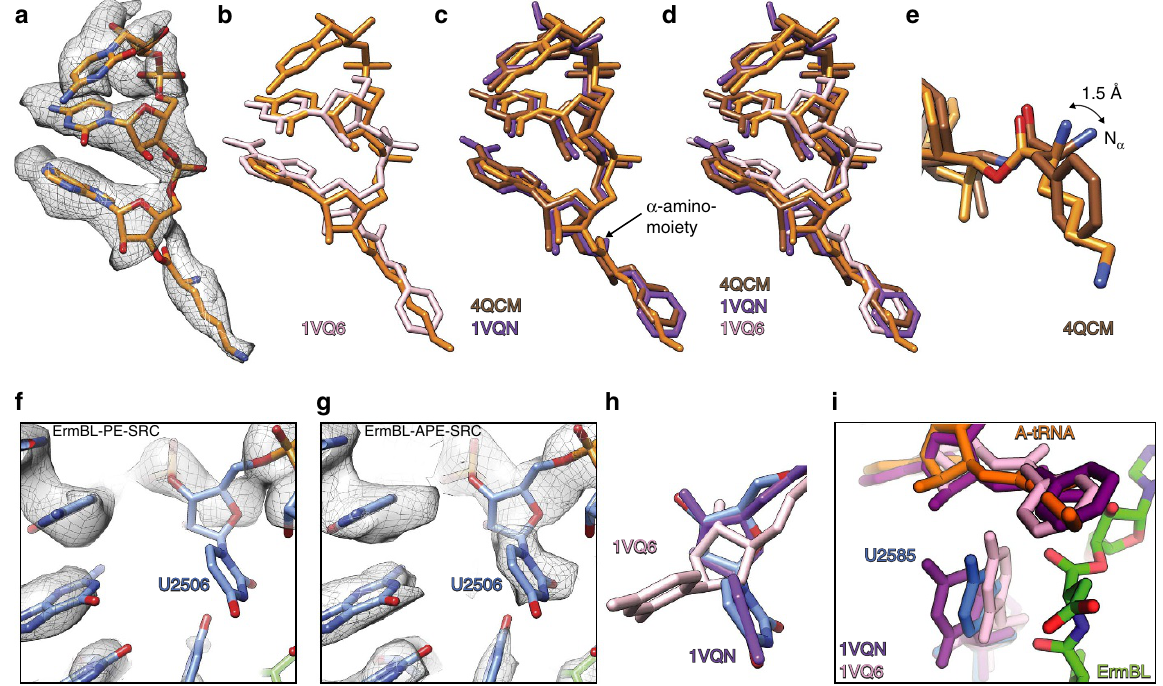
Figure 5 | A-site tRNA accommodation at the PTC of the ErmBL-APE-SRC. ( a – d ) Atomic model for the CCA end of the A-site tRNA (orange) and ( a ) electron density (grey mesh) in the ErmBL-APE-SRC compared with ( b ) unaccommodated (pink, PDB1VQ6 (ref. 30)) and ( c ) accommodated states (brown, PDB4QCM 32 ; purple, PDB1VQN 30 ) and ( d ) with both. ( e ) Positions of the a -amino group of the amino acid attached to the A-site tRNA in the ErmBL-APE-SRC compared with its position in the pre-peptide-bond formation state 32 . ( f – h ) Position of 23S rRNA nucleotide U2506 (blue) in ( f ) ErmBL-PE-SRC and ( g ) ErmBL-APE-SRC including electron density (grey mesh) and ( h ) compared with the unaccommodated and accommodated states of the PTC 30 . ( i ) Comparison of 23S rRNA nucleotide U2585 in ErmBL-APE-SRC (blue), compared with the unaccommodated and accommodated states of the PTC 30 . The nascent chain and A-tRNA in ErmBL are shown in green and orange,